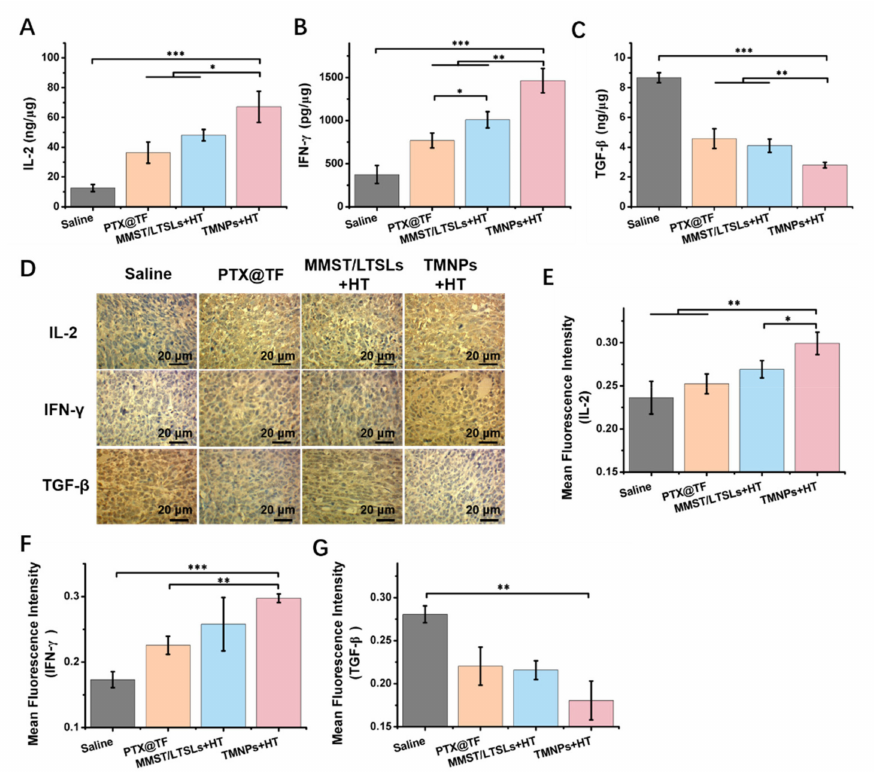
Figure 6. Alternation of immune-related cytokines by TMNPs in tumors. Quantitative analysis of ( A ) IL-2, ( B ) IFN- γ and ( C ) TGF- β in tumor tissues. Breast tumor fragments were harvested at day 29 after tumor implantation. Cytokines were measured by ELISA kit (mean ± SEM, n = 3, * p < 0.05, ** p < 0.01, *** p < 0.001). ( D ) Immunochemistry staining of IL-2, IFN- γ and TGF- β in tumor tissues. The scale bar is 20 µ m. Integrated optical density (IOD) of ( E ) IL-2, ( F ) IFN- γ and ( G ) TGF- β in tumor tissues were quantified by Image Pro Plus (ImageJ 1.8.0, mean ± SEM, n = 3, * p < 0.05, ** p <